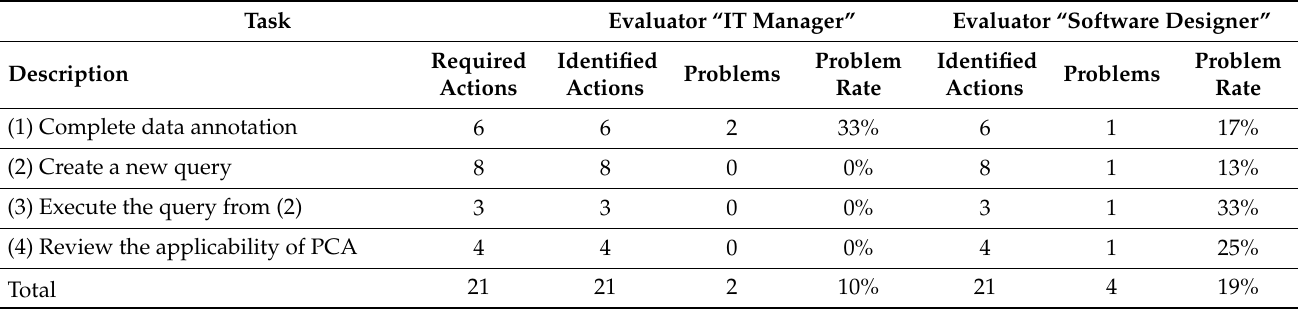
Table 2. Cognitive walkthrough results with ground truth actions comparison and identified prob-